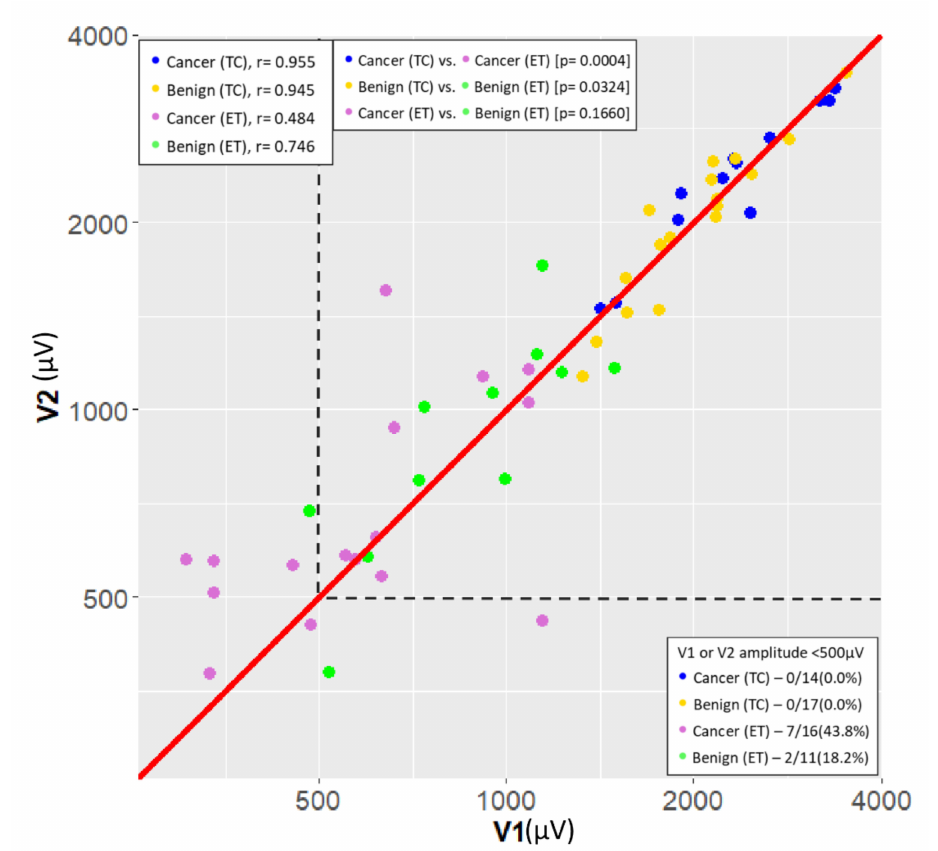
Figure 2. Scatterplot (logarithmic scale) of the correlation between V1 signal ( µ V) and V2 signal ( µ V), and the correlation coefficient (r) in the four groups. Blue point = Cancer (TC) group: thyroid cancer patient with surgery performed under TC- IONM, r = 0.955; Yellow point = Benign (TC) group: benign thyroid disease patient with surgery performed under TC-IONM, r = 0.945; Purple point = Cancer (ET) group: thyroid cancer patient with surgery performed under ET-IONM, r = 0.484; Green point = Benign (ET) group: benign thyroid disease patient with surgery performed under ET-IONM, r = 0.746. Cancer (TC) group showed significantly higher signal stability compared to the Cancer (ET) group, p = 0.0004. Benign (TC) group showed significantly higher signal stability compared to the Benign (ET) group, p = 0.0324. Cancer (ET) group showed non-significantly lower signal stability compared to the Benign (ET) group, ( p = 0.0160). However, 7/16 nerves (43.8%) in Cancer (ET) group with V1 or V2 amplitude <500 µ V showed higher rate than 2/11 nerves (18.2%) in Benign (ET) group. Additionally, no nerves in the Cancer (TC) group or the Benign (TC) group had V1 or V2 amplitude <500 µ V. Overall, TC-IONM had higher signal stability and quality compared to ET-IONM in the thyroid cancer patients. TC = transcartilage; ET = endotracheal tube; IONM = intraoperative